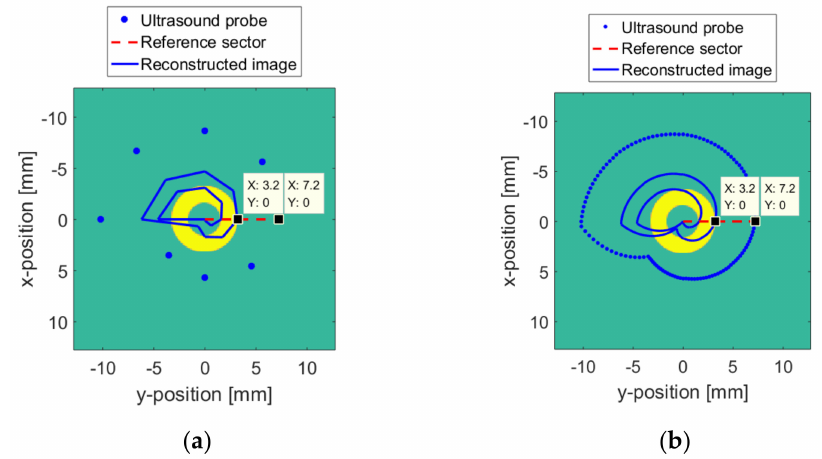
Figure 17. Reconstructed image when the surface changes without the probe sector matching (PSM): ( a ) ∆ v = 8; ( b ) ∆ v = 128.